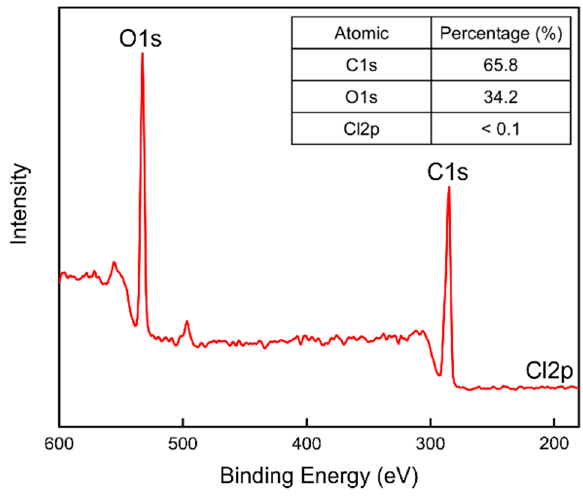
Figure 15. XPS profile of the sandwich-structured PVA-based hydrophobic composite film.